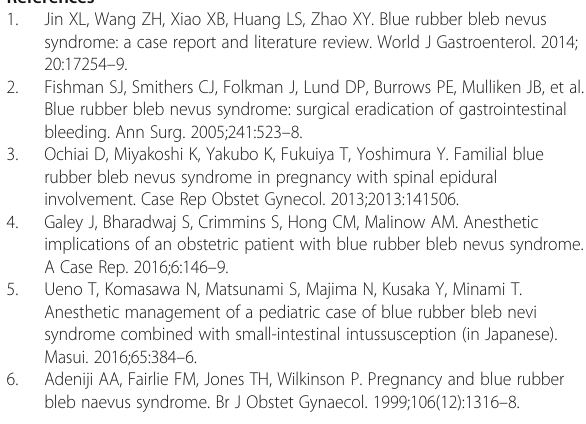
Abbreviations BRBNS: Blue rubber bleb nevus syndrome; MRI: Magnetic resonance imaging Acknowledgement Not applicable.